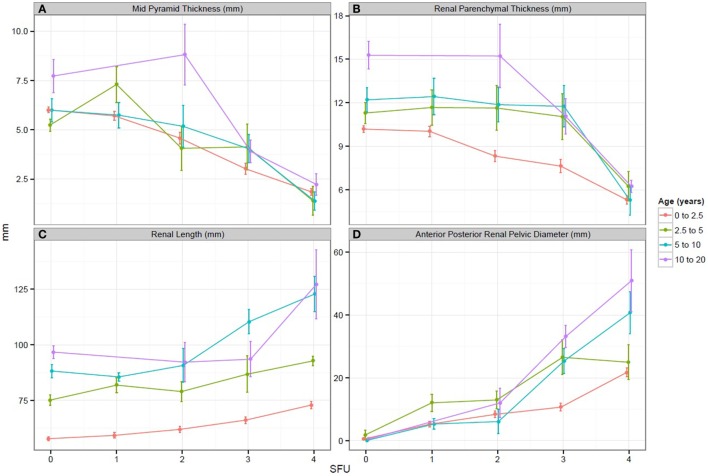
(A–D) Graphs representing the change in each sonographic renal parenchymal measurements with worsening hydronephrosis. SFU, society of fetal urology hydronephrosis grade.